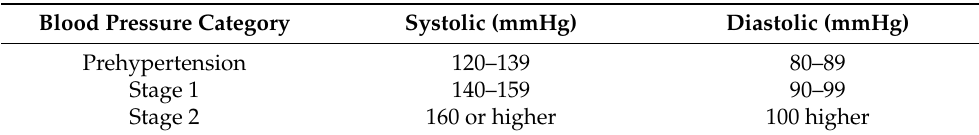
Table 3. Blood pressure level category. Blood Pressure